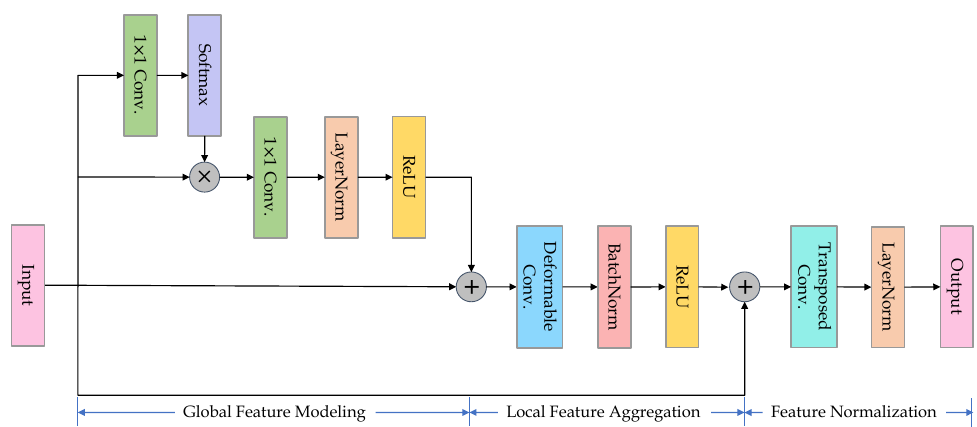
Figure 2. The structure of the proposed global feature mining and aggregation (GFMA)